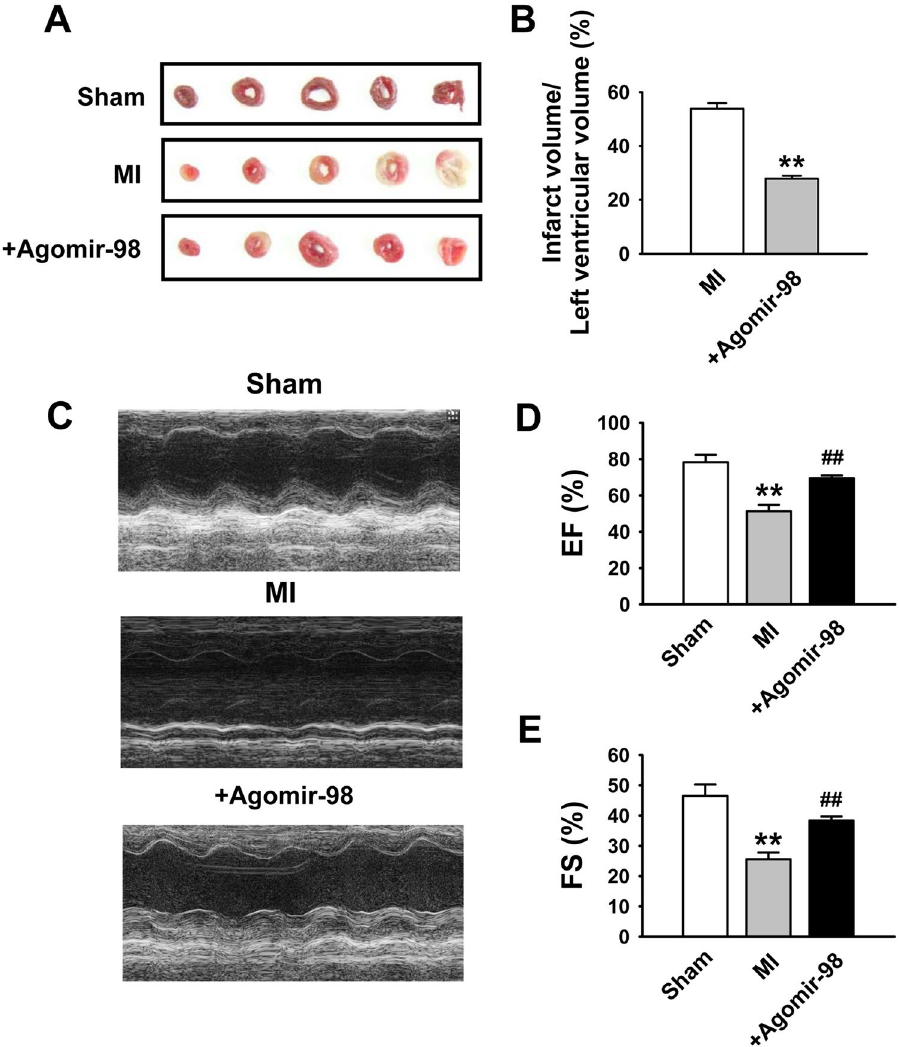
Figure 7. Reduction of infarct size and improvement of cardiac function by miR-98 in MI mice. ( A ) Representative images showing infarct areas in cross section slices. ( B ) Statistical analysis of IA/LV ratio. IA: infarct area, LV: left ventricles. n = 3. ** P < 0.01 versus MI group. ( C ) Representative photographs of